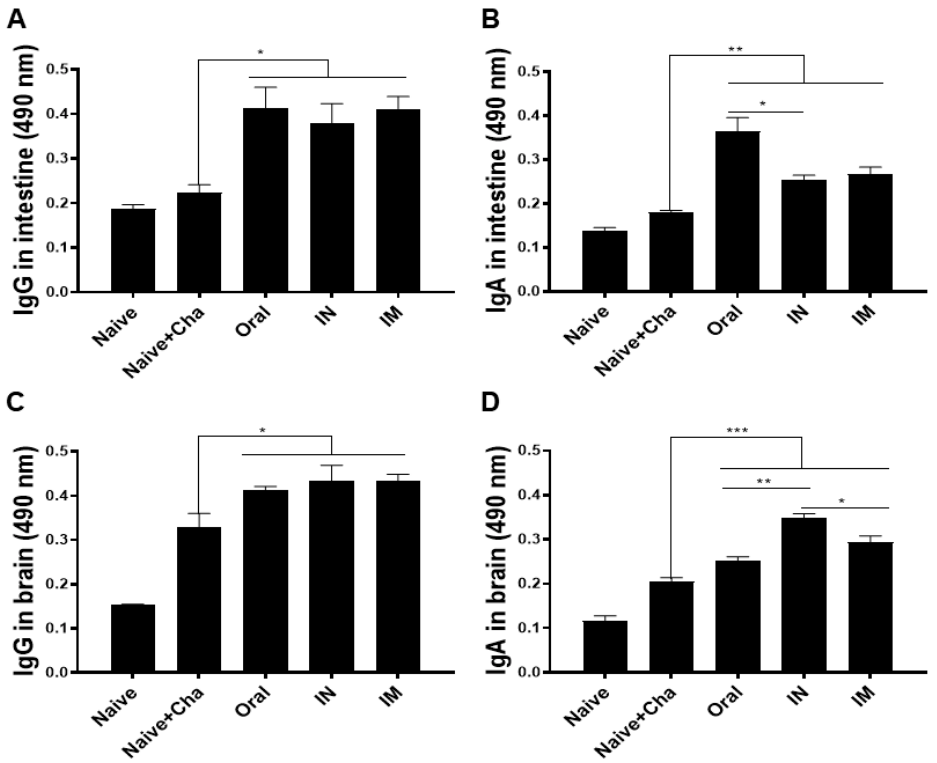
Figure 3. T. gondii -specific IgG and IgA antibody responses were observed by ELISA from the intestinal ( A , B ) and brain ( C , D ) tissue samples. Data are presented as mean ± SD and asterisks indicate statistical differences between groups. (* p < 0.1, ** p < 0.01, *** p < 0.001). All samples were acquired on an individual basis and a total of three independent experiments were performed in triplicates.